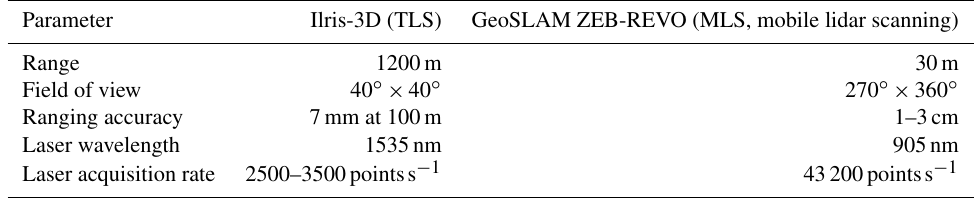
Table 3. Main characteristics of lidar